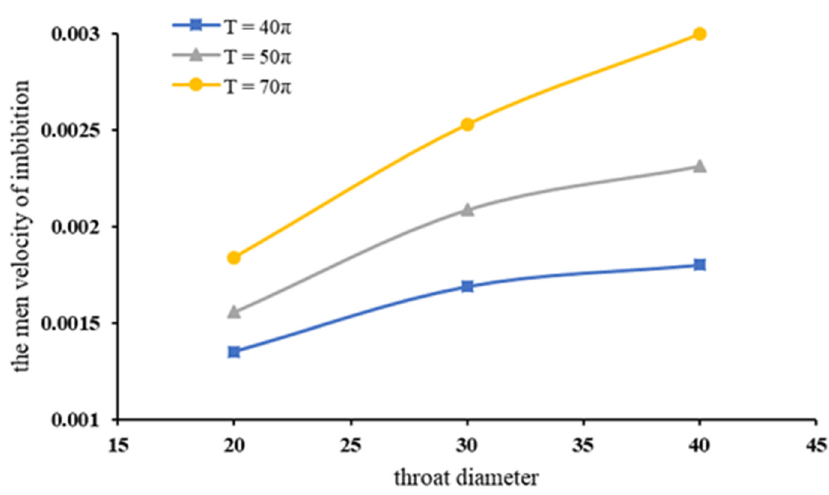
Figure 17. The relation between the mean velocity of spontaneous imbibition and the throat when the pore-throat aspect is fixed (pore-throat aspect ratio = 3).